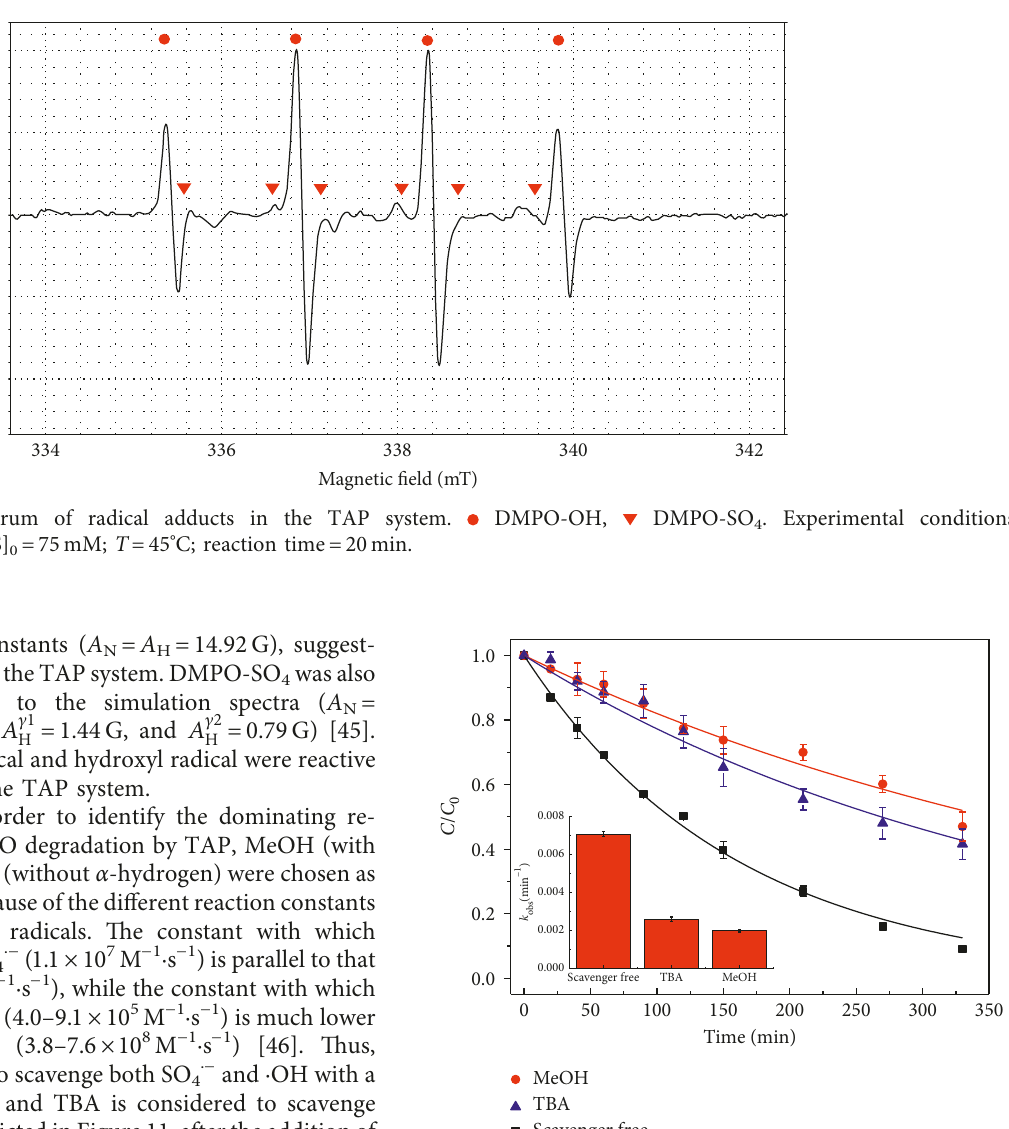
Figure 11: Effects of different scavengers on AMO degradation by TAP. Solid lines represent the pseudo-first-order kinetic model fits. Insert: changes of k obs at different scavengers. Experimental con- ditions: [AMO] 0 � 0.1 mM; [PS] 0 � 10mM; T � 50 ° C, [alcohol] 0 / [PS] 0 /[AMO] 0 � 30000:100:1; reaction time �